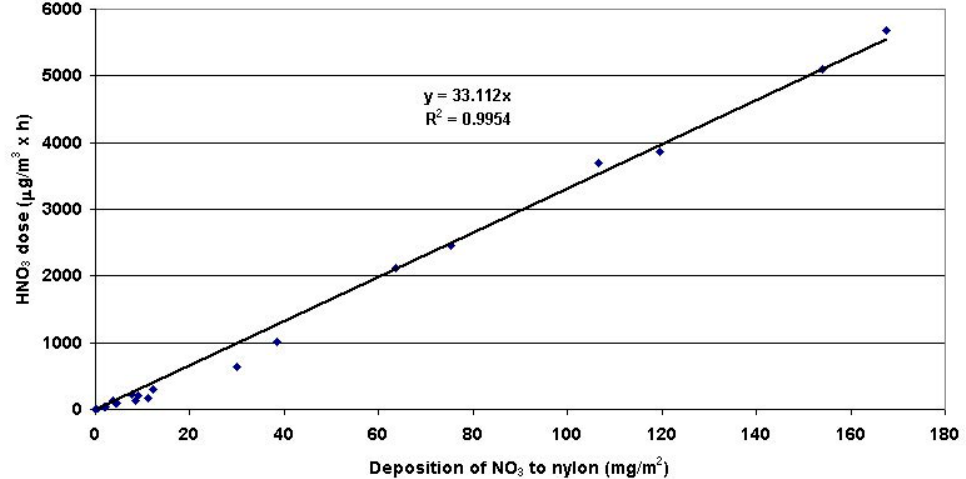
FIGURE 1. Calibration of nylon filters as collecting medium in the HNO 3 passive samplers. Calibration curve was developed in the CSTR chambers with controlled levels of HNO 3